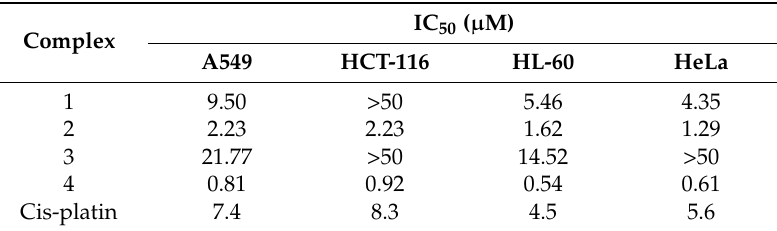
Figure 9. The inhibition effects of complex 1 on the three cell lines at different concentration (6.25, 12.5, 25, and 50 µ M). Table 2. The IC 50 values of the complexes on cancer